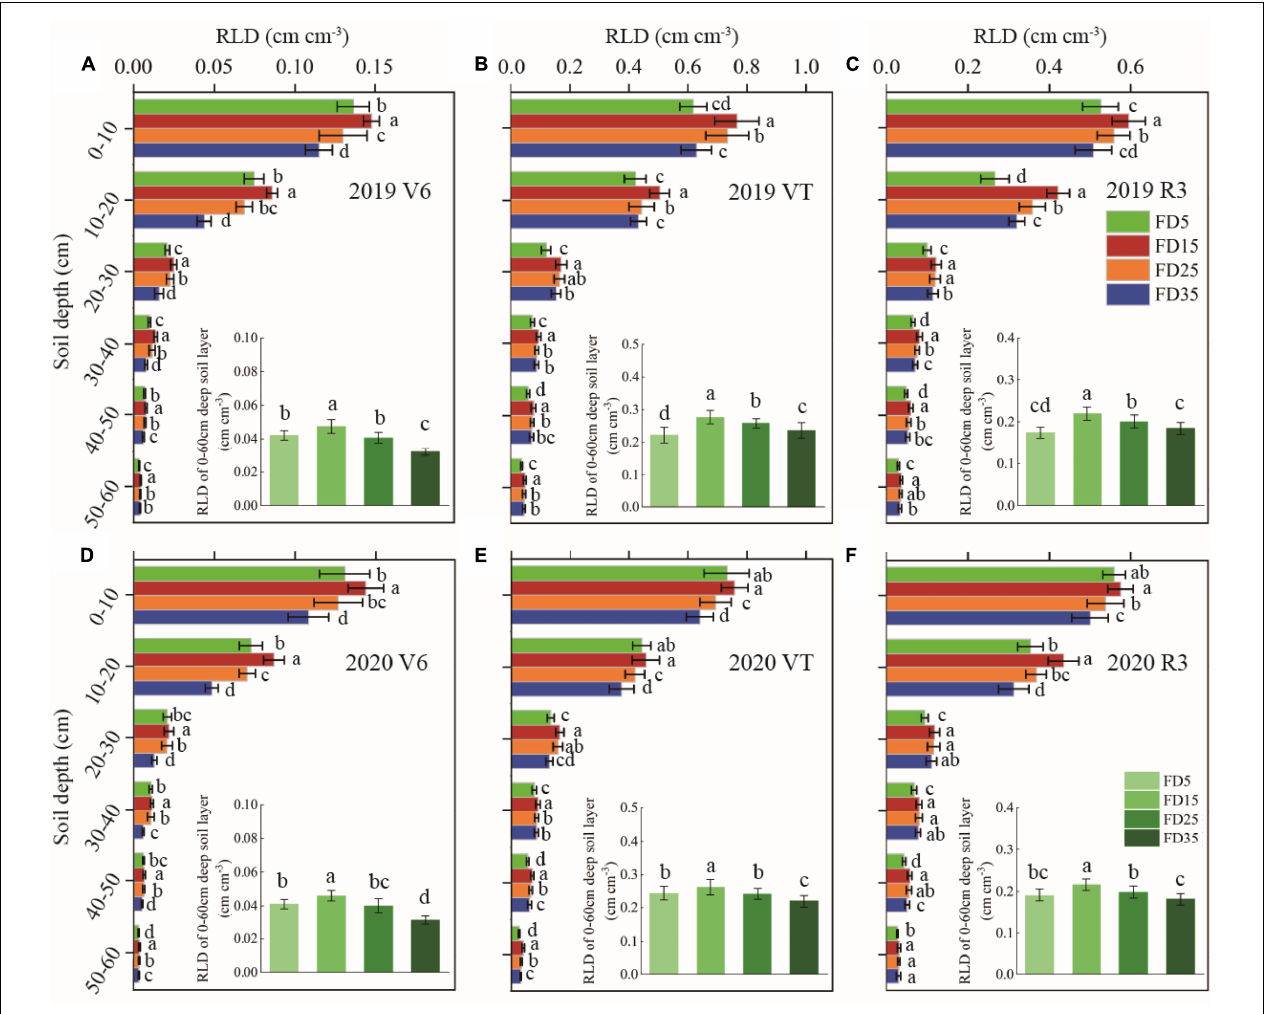
FIGURE 3 | Effects of fertilizer application depths on root length density (RLD) at V6, VT, and R3 stages of summer maize in 2019 (A–C) and 2020 (D–F) . FD5, fertilizer application at a depth of 5 cm; FD15, fertilizer application at a depth of 15 cm; FD25, fertilizer application at a depth of 25 cm; and FD35, fertilizer application at a depth of 35 cm. The vertical bars stand for standard deviation. The different lowercase letters indicate a significant difference among the treatments at P < 0.05 using the LSD